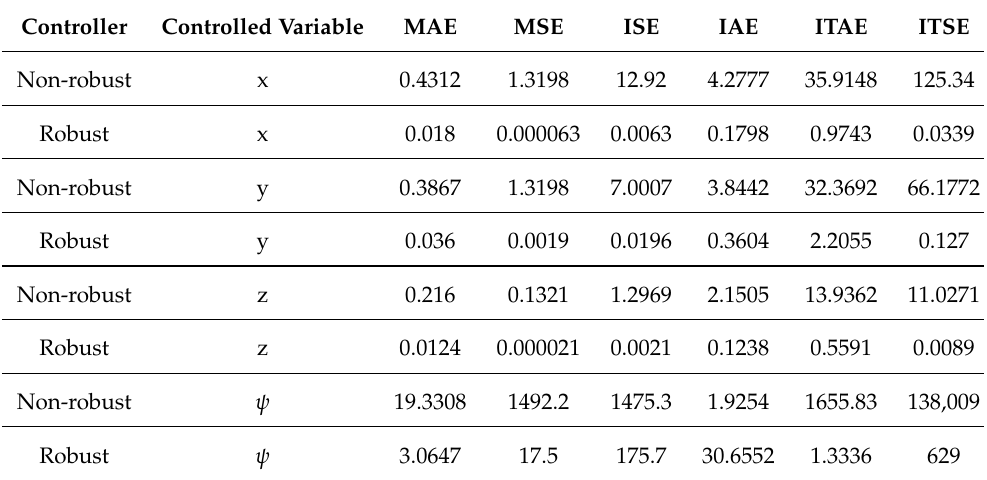
Table 4. Performance indices for the x, y, z and ψ tracking errors.